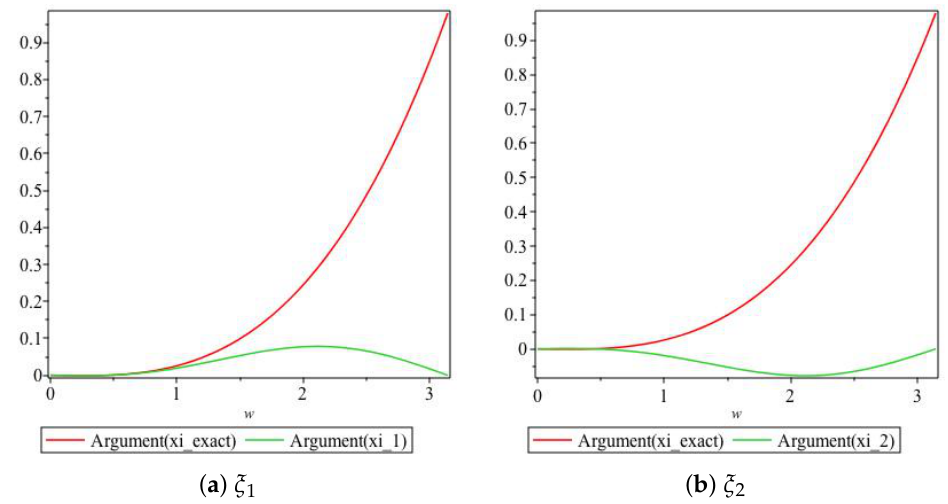
Figure 5. Plot of the arguments of the exact and numerical amplification factors of Scheme 1 for Numerical Experiment 1 with the spatial and temporal step sizes h = π /10 and k = 0.001,